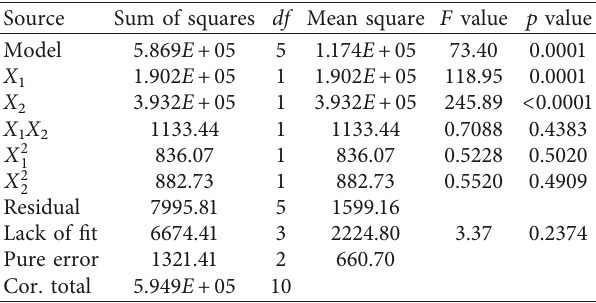
Table 5: Analysis of variance (ANOVA) for N ( R 2